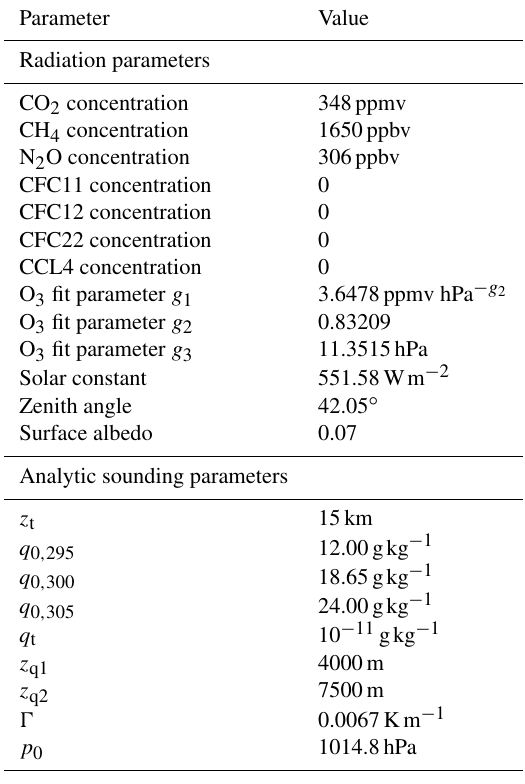
Table 2. Radiation and initialization parameters.